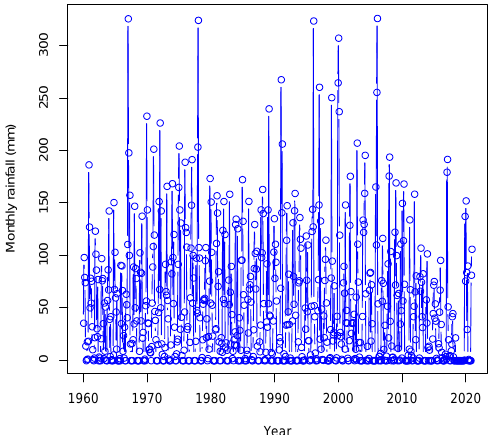
Figure 3. Scatter plot of monthly rainfall data.